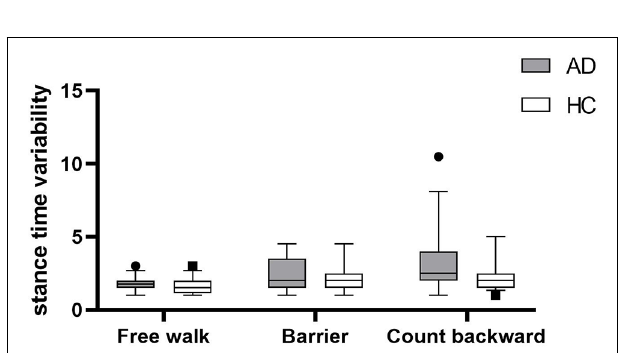
FIGURE 2 | The comparison of stride time variability between patients with AD and HCs in the walking of Free walk, Barrier, and Count backward. ∗ P < 0.05.